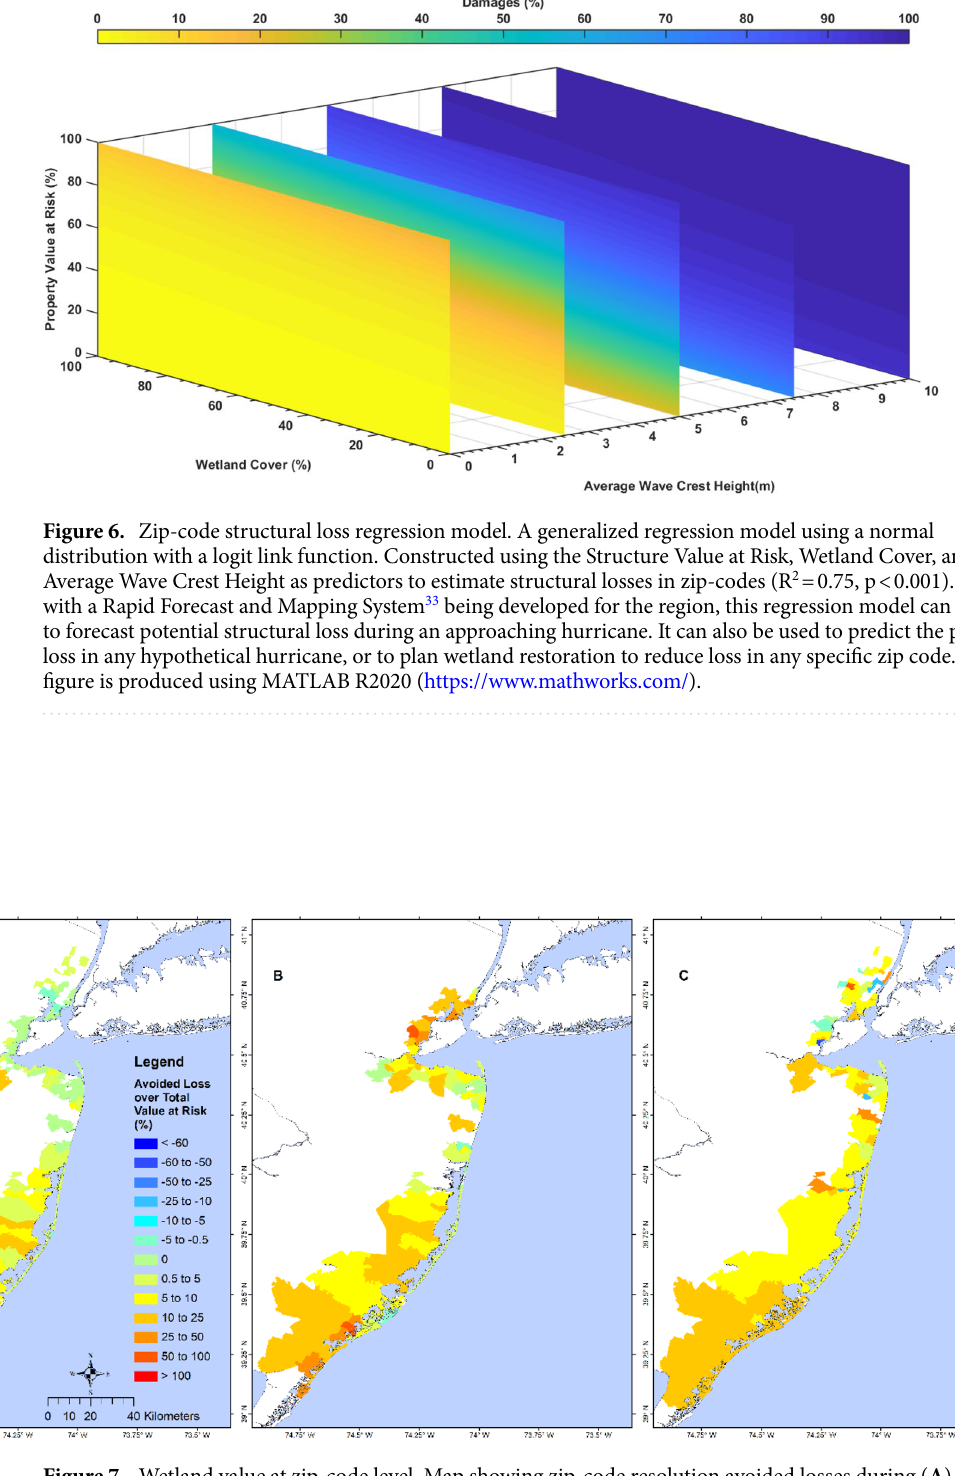
Figure 7. Wetland value at zip-code level. Map showing zip-code resolution avoided losses during ( A ) Sandy, ( B ) BS storm, and ( C ) 1% annual flood and wave, as a percentage of the total at-risk property value of the without wetlands scenario. Dark red values show zip-code with the highest wetland value while dark blue areas show the least wetland value. Negative values indicate that the presence of wetland would increase structural losses and positive values indicate that wetland would lower the structural losses. These maps show that wetland values for NJ are mostly between low (< 10%) and modest (10–25%). These maps, along with the wetland value regression model developed in this study, can be used by local planners to develop resiliency and restoration plans to increase the wetland coverage area and enhance the wetland value. Maps for NY and CT are unavailable due to unavailability of structural data there. The map is produced using ESRI ArcGIS Pro 2.7 (https ://www.esri. com/en-us/arcgi s/produ cts/arcgi s-pro/overv